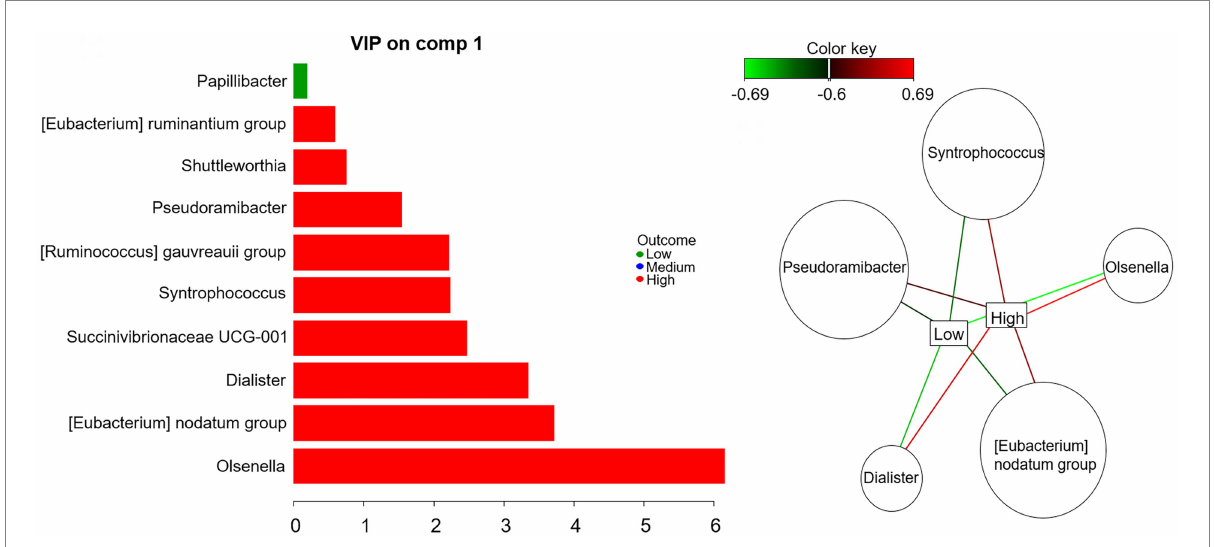
FIGURE. 2 Mint sparse partial least square discriminant analysis on rumen bacterial genera: variable importance in projection (left) and relevance network with a 0.6 cut-off